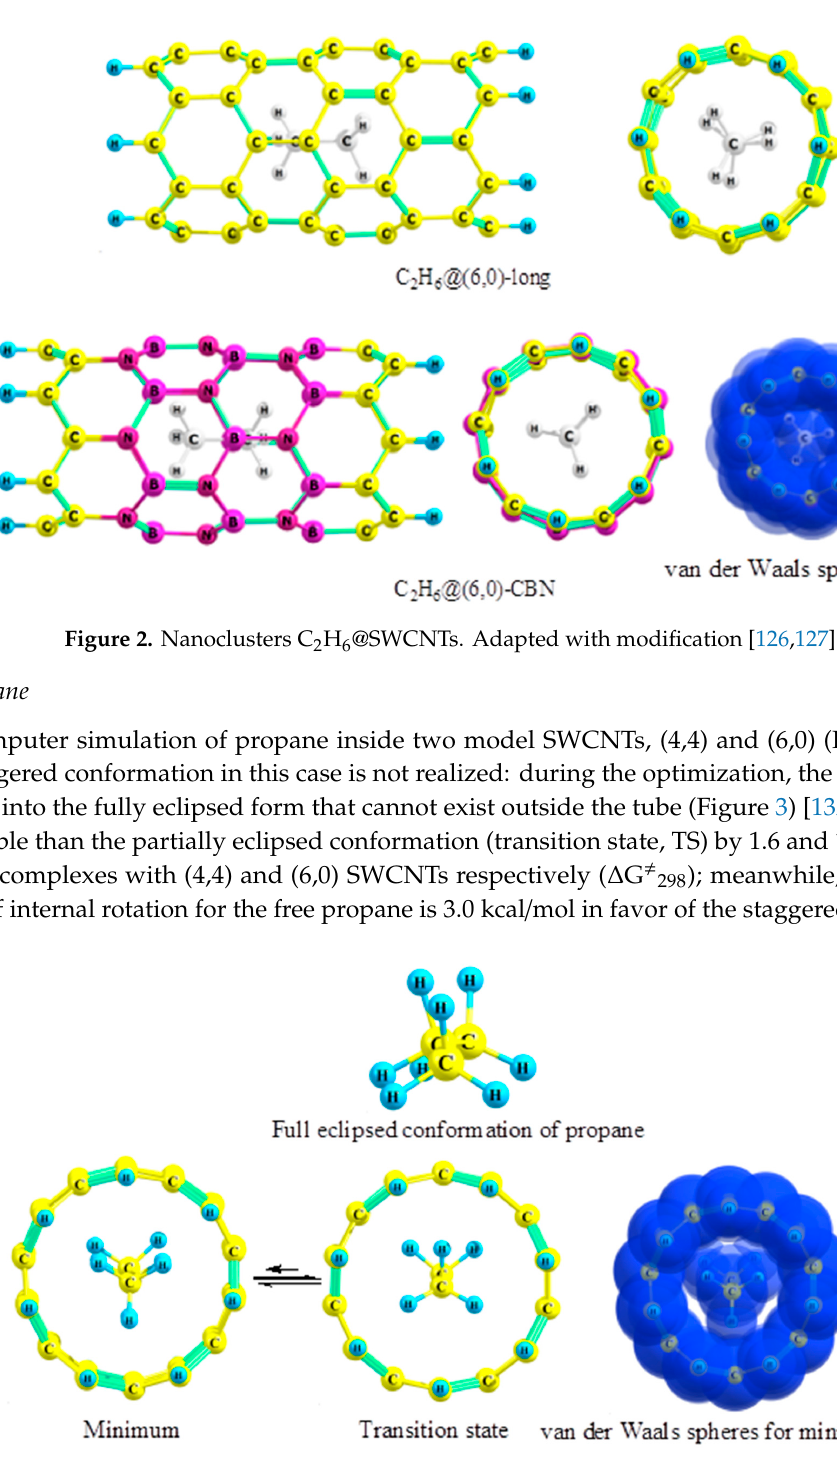
Figure 4. Conformational equilibrium in cluster C 8 H 18 @(5,5). Adapted with modification [134]. The relative stability of the eclipsed form is 0.9 kcal/mol ( Δ G ≠ 298 ); the length of the central C − C bond is 1.522 Å (shorter by 0.068 Å than in the free alkane). The encapsulated molecule acquires a negative electric charge ( − 0.93) [134]. 2.4. 2,2-Dimethylpropane 2,2-Dimethylpropane (neopentane) is a convenient model system for investigation of the interconnection between the rotational barrier and the molecular environment around the rotator [124,135]. The experimental barrier to internal rotation ( Δ G 298 ≠ ) is 4.3 kcal/mol [136,137]. However, the conformational behavior of neopentane inside nanotubes differs significantly from that of ethane and its analogs discussed above. Its main feature is a substantial increase in the internal rotation barrier in the case of endocomplexes with SWCNTs of small diameter; TS corresponds to the eclipsed